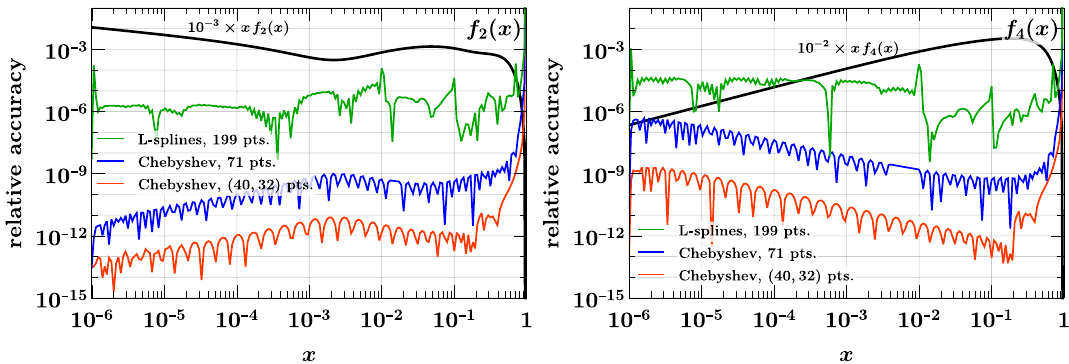
Fig. 3 Relative interpolation accuracy for the sample PDFs f 2 ( x ) and f 4 ( x ) in Eq. (37). The L-splines (green) use the high-density grid with n pts = 199. The Chebyshev interpolations use grids with n pts = 71, either with a single subgrid (blue) or with two subgrids [ 10 − 6 , 0 . 2 , 1 ] ( 40 , 32 )